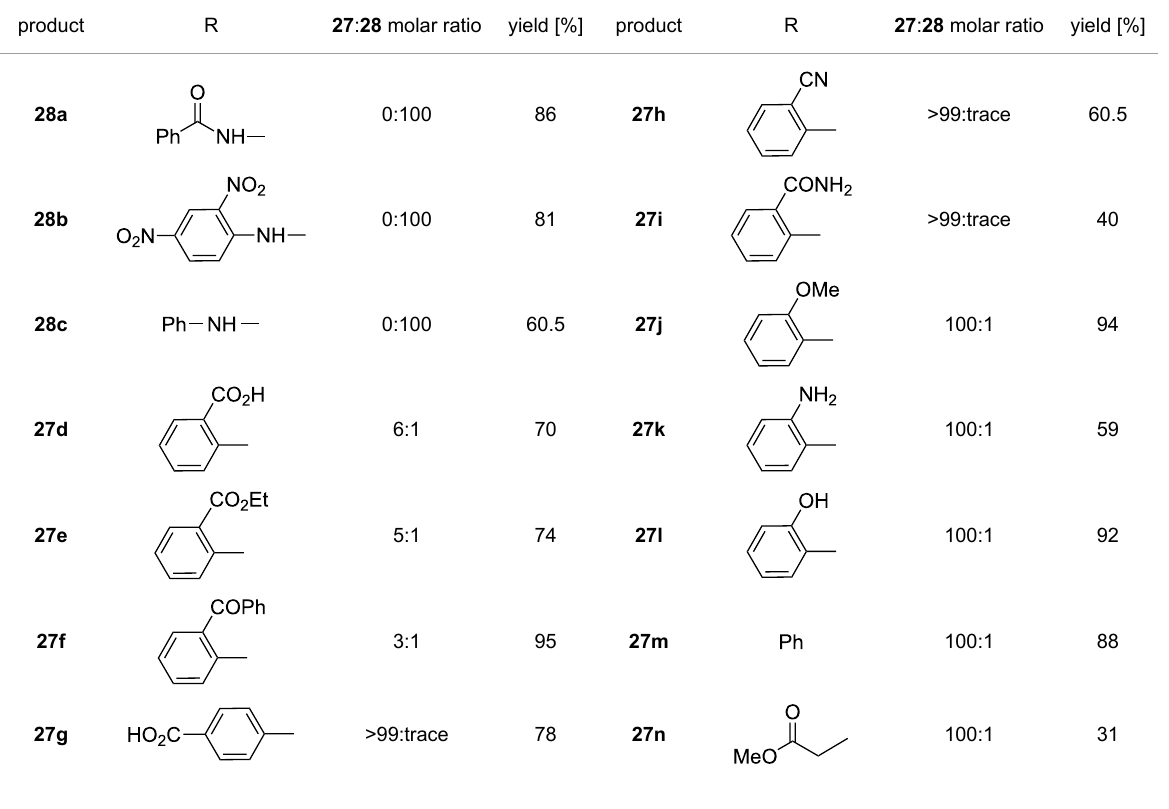
Table 3: Products of reaction of 2-propynyltriphenylphosphonium bromide with amines [33].